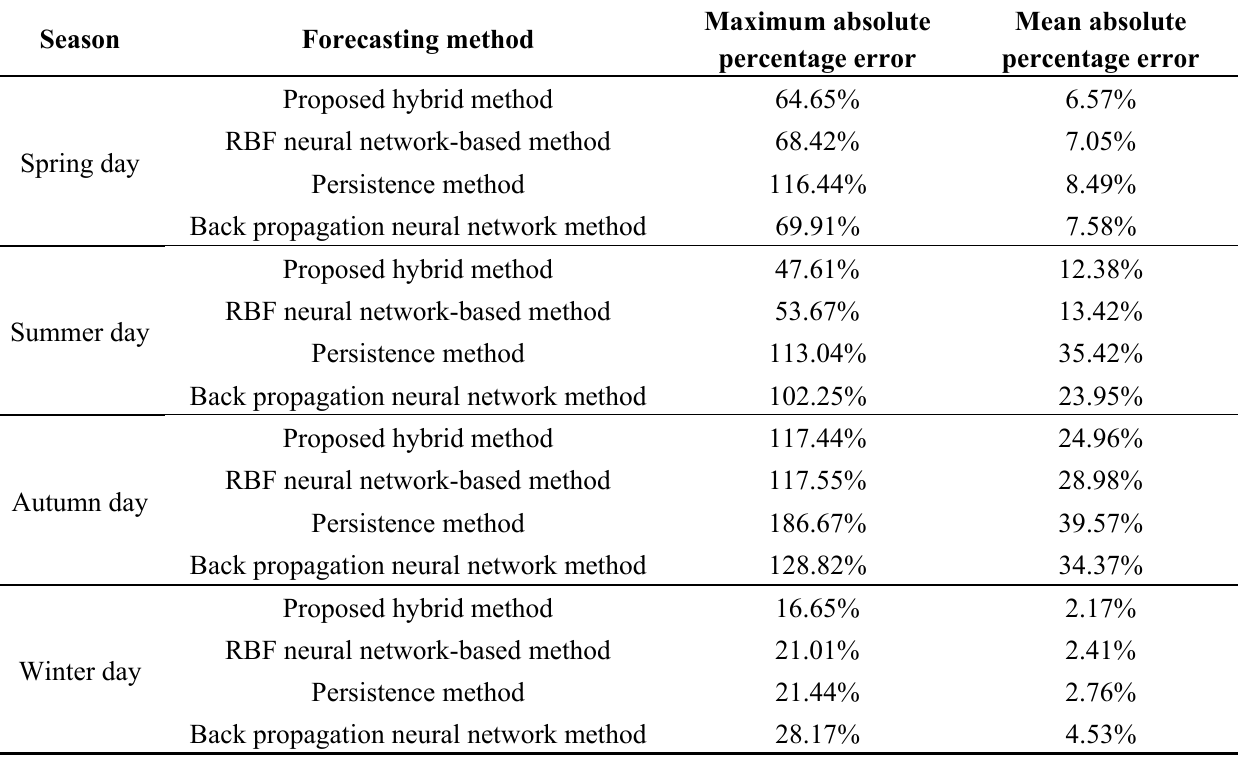
Table 1. The accuracy evaluation of the four methods for wind power